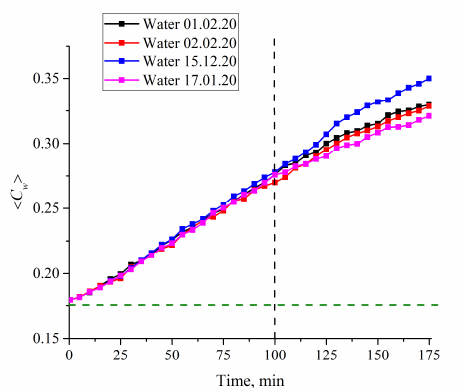
Figure 10. Average (over the distance L = 200 μm between the windows of the cell) concentration of water (cid:104) C w ( t ) (cid:105) vs. the time of swelling for ordinary water received on different days from various Milli-Q plants. It is seen that the graphs actually coincide to one another within the first 100 min of swelling. The horizontal dashed line is water concentration for dry Nafion (baseline).